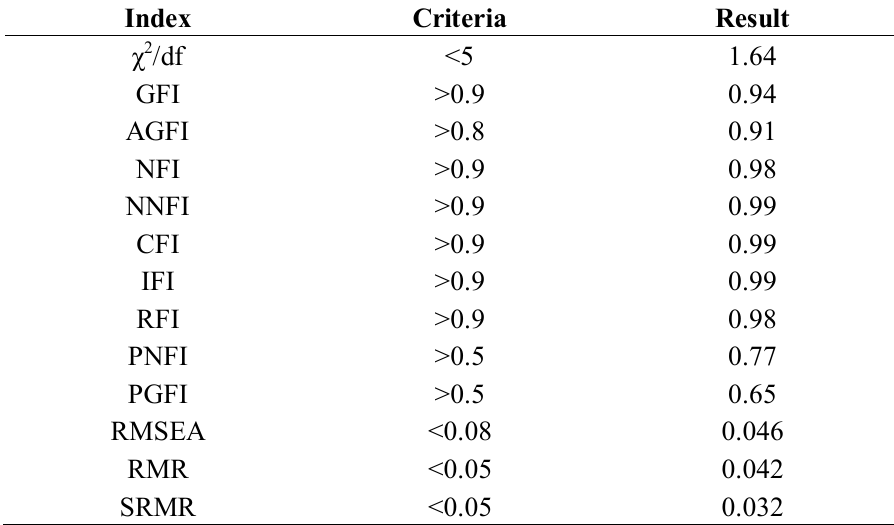
Table 4. The fitness of the model.